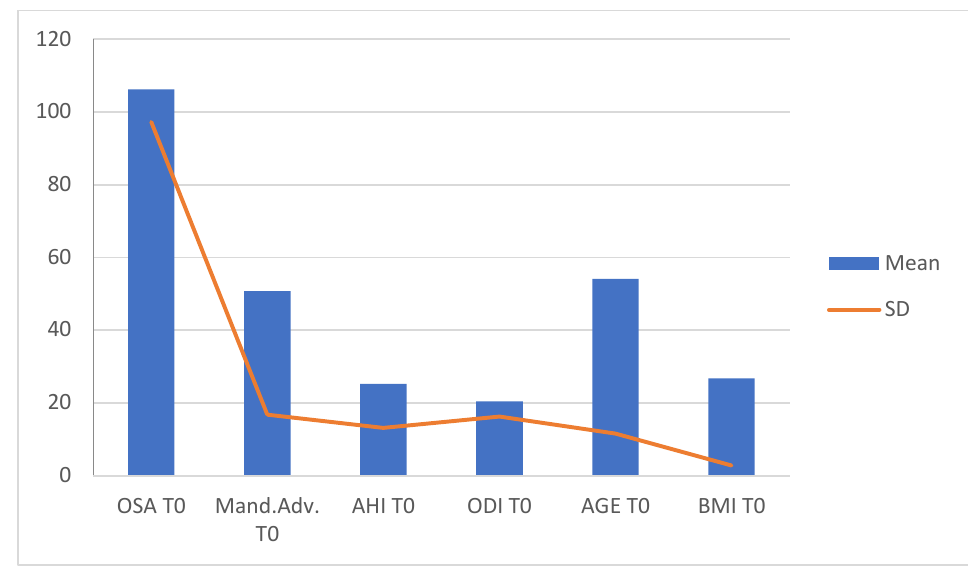
Figure 3. Descriptive variables table in patients who neither developed nor increased the number of CSA.